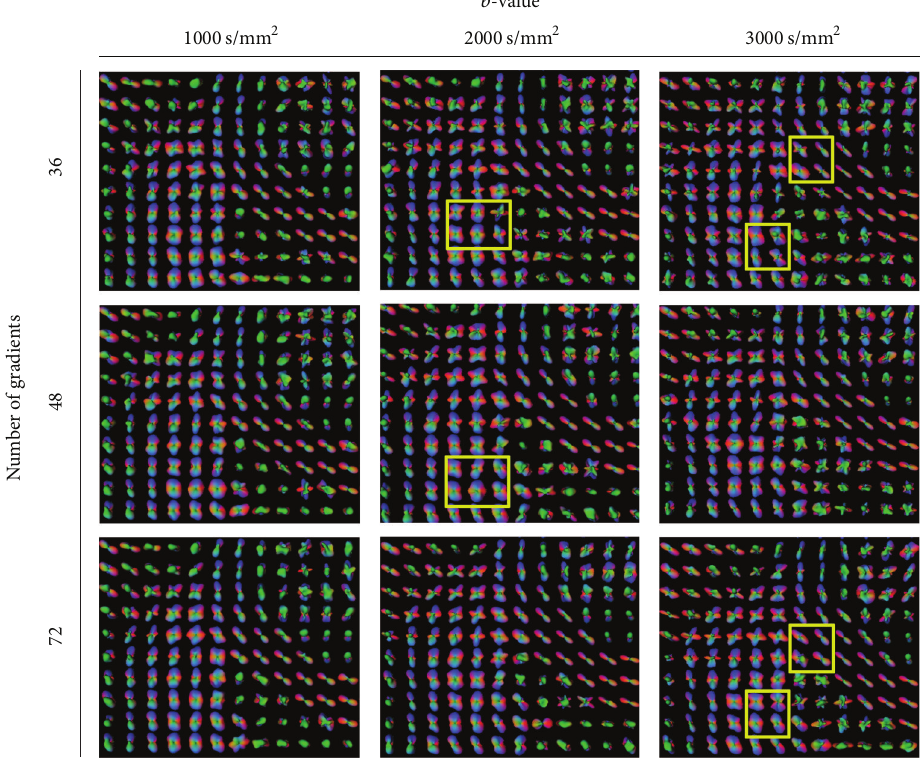
Figure 11: The effect of the 𝑏 -value and the number of gradients at 𝑙 = 6 . At higher 𝑏 -values we observe many spurious peaks that disappear with the increase of the number of gradients (see yellow marked rectangles). At NG ≥ 46 there is not a significant difference between the profiles at 𝑏 = 2000 s / mm 2 and 𝑏 = 3000 s / mm 2 . Given that the spurious peaks are slightly more prominent at 𝑏 = 3000 s / mm 2 , and that lower 𝑏 -values are more attractive with respect to the total scanning time, we conclude that 𝑏 = 2000 s / mm 2 and NG ∈ [48; 72] are the optimal combination of